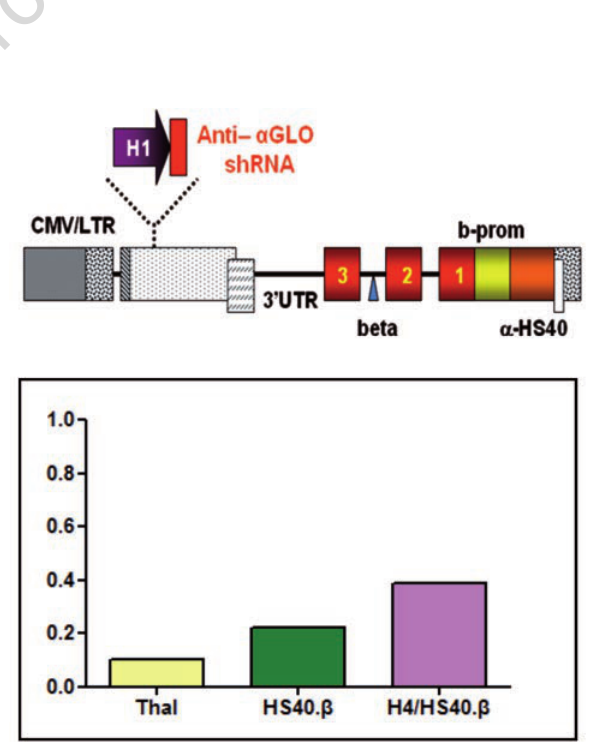
Figure 6. Diagram of the combination vector. Shown in the lower panelare the b/a globin ratios obtained in untransduced (thal), HS40. b and H4.HS40. b vector transduced CD34+ cells grown under liquid erythroid culture